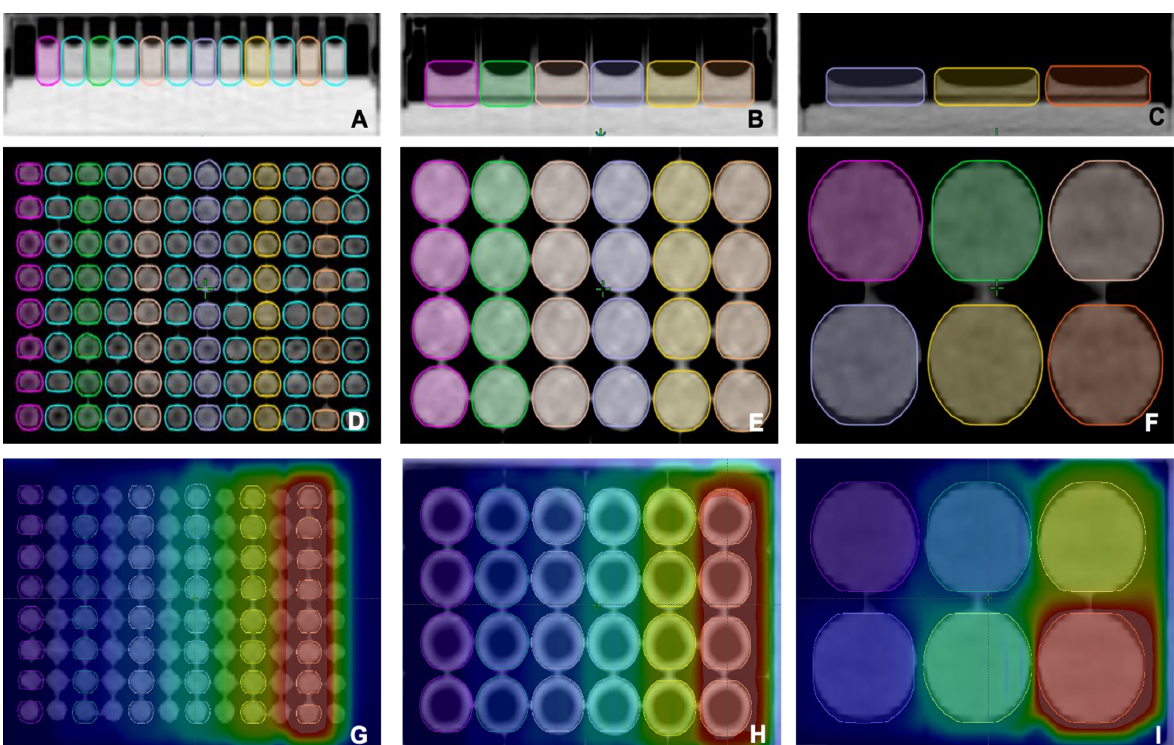
Figure 2. ( A – C ) Coronal view of 96-, 24-, and 6-well tissue culture plates showing contouring of wells. ( D – F ) Axial view of 96-, 24-, and 6-well tissue culture plates showing contouring of wells (in 96-well plate contouring, alternate columns of wells were sacrificed during IMRT planning). ( G – I ) Multiwell tissue culture plate IMRT plans. Contouring are colour-coded (pink—0 Gy, purple—2 Gy, green—4 Gy, yellow—8 Gy, light pink—16 Gy, and orange—24 Gy). Radiation absolute dose distributions are shown as dose wash (purple—0 Gy, blue—2 Gy, light blue—4 Gy, turquoise—8 Gy, yellow—16 Gy, and red—24 Gy).